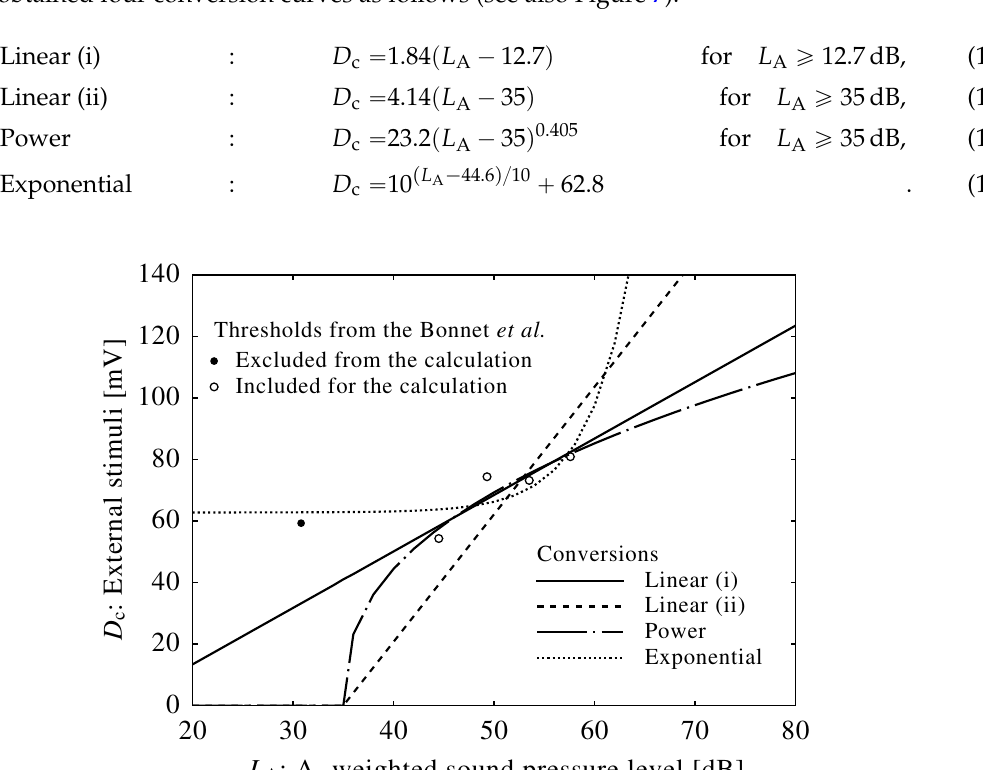
Figure 7. Experimental and mathematical results (see Table 1, white and black circles) and conversion curves of neuroelectrical stimuli to sound pressure levels. Note that the threshold falling after five minutes (black circle) was excluded from the calculation for obtaining